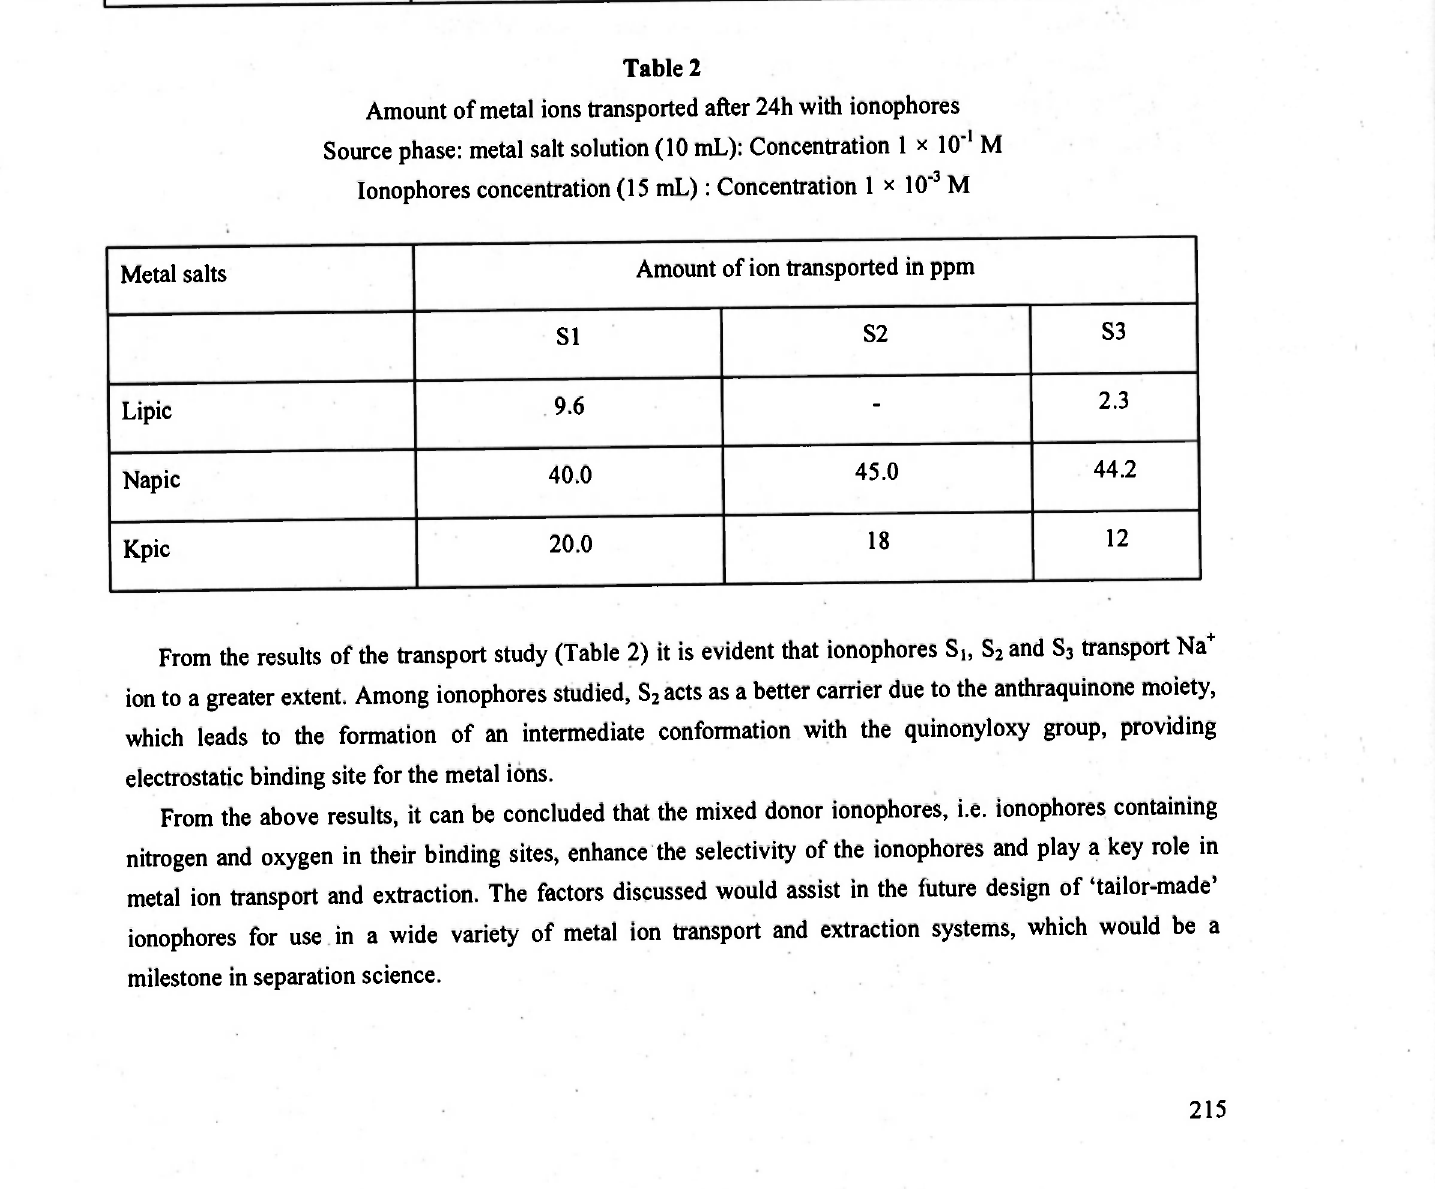
Amount of metal ions extracted after 4h with ionophores.